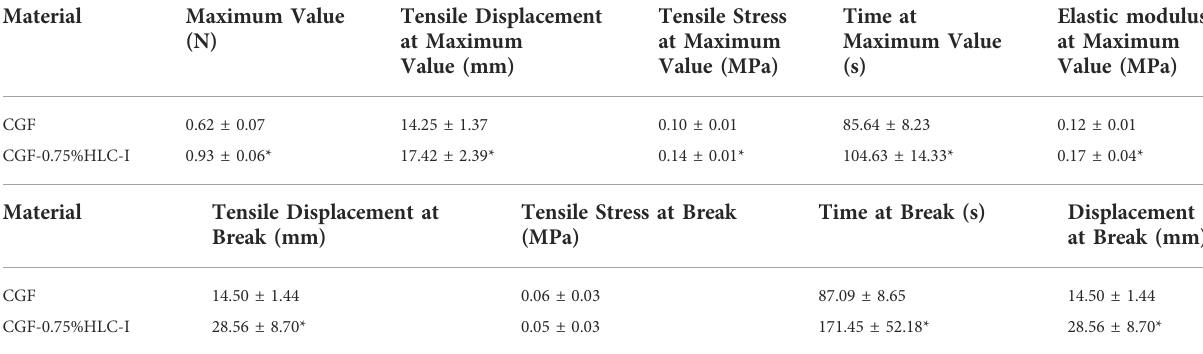
TABLE 2 Biomechanical properties of CGF membrane and CGF-0.75%HLC-I composite bio fi lm (X ± S).